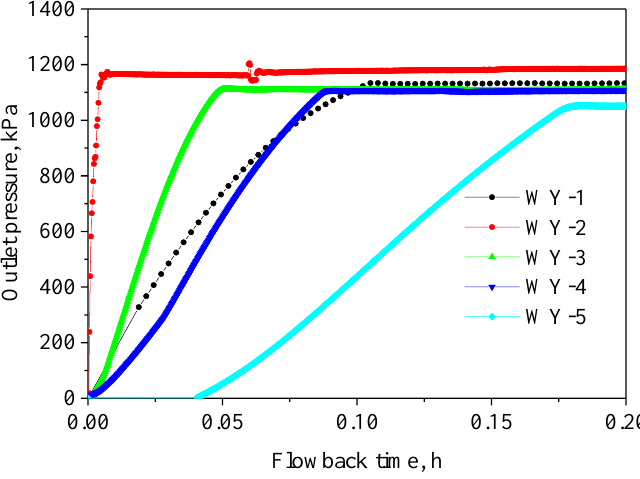
Figure 4. Relationship between outlet pressure and flowback time of five shale samples.